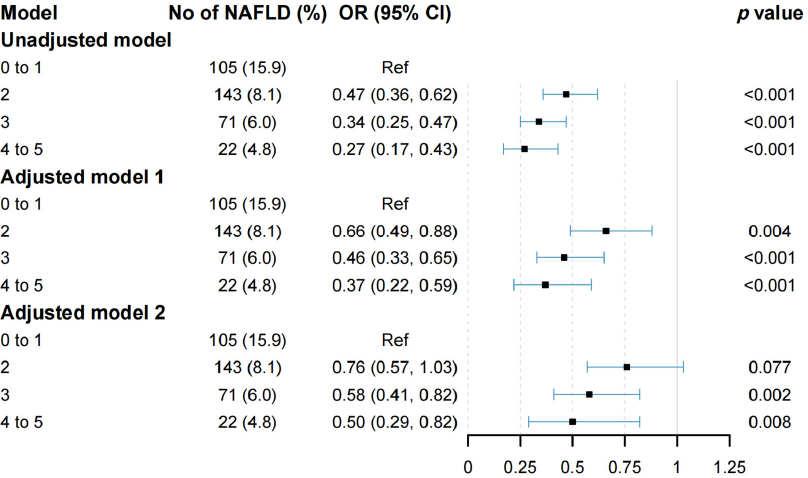
Figure 2. Logistic regression of healthy lifestyle scores and NAFLD. NAFLD, non-alcoholic fatty liver disease; OR, odds ratio; CI, confidence interval.